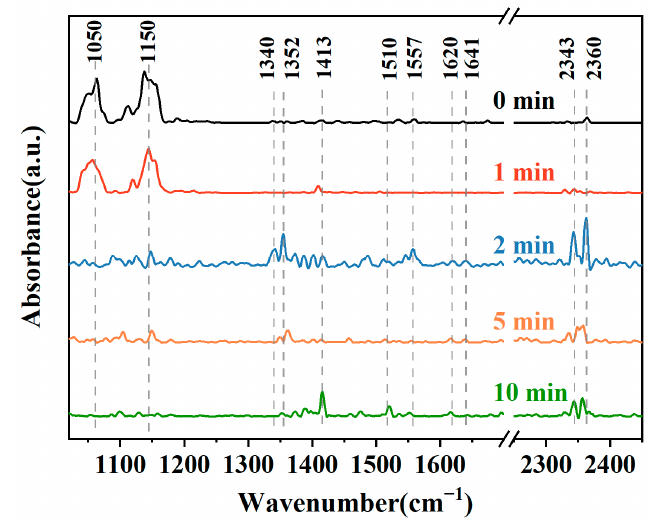
Figure 11. In situ FTIR spectra of the MXene/NiO-P2 sensor exposed to HCHO.